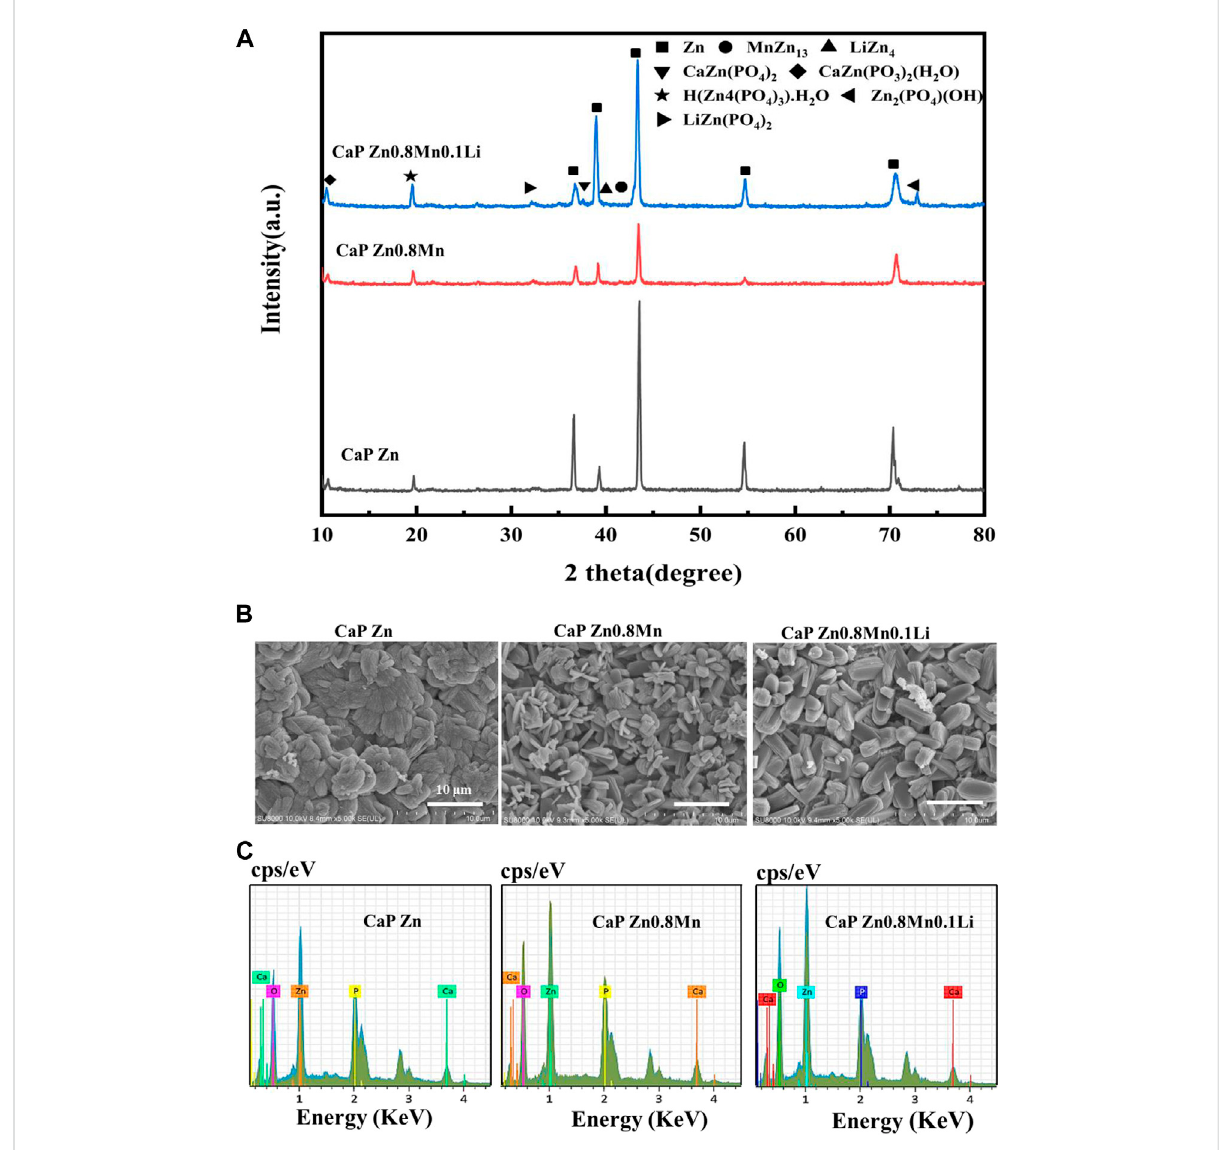
FIGURE 6 The microstructure and composition of CaP-coated Zn, Zn0.8Mn, and Zn0.8Mn0.1Li. (A) XRD spectrum. (B) Surface morphologies by FESEM. (C) The EDS spectra and relative contents of each element.